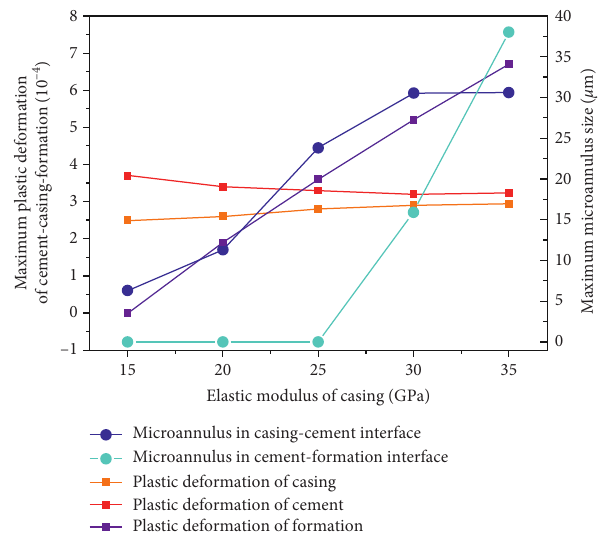
Figure 14: Influence of the elastic modulus of the formation on microannulus